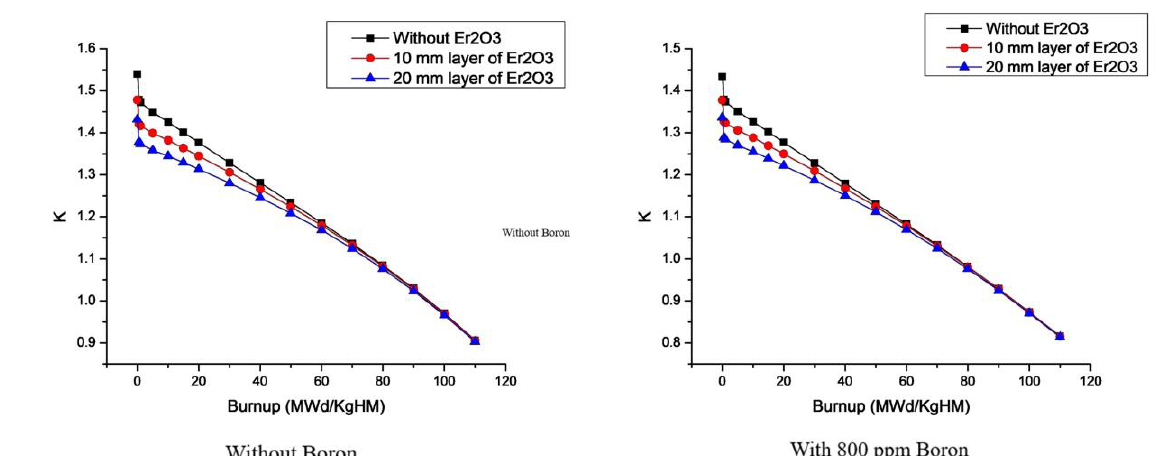
Figure 12. Full core burnup with Er